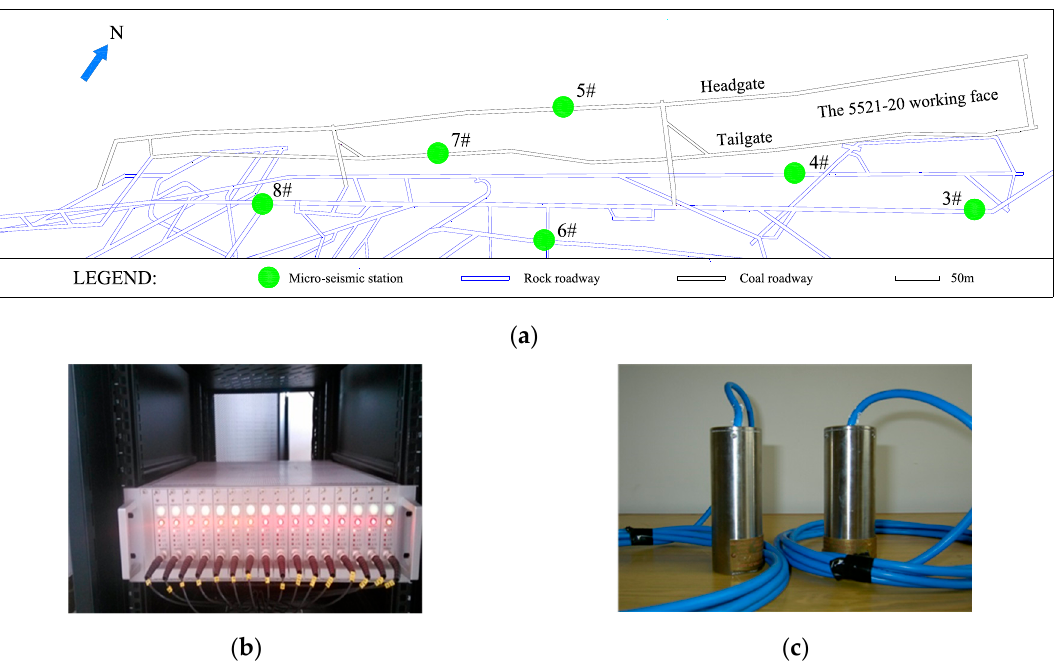
Figure 12. SOS micro ‐ seismic monitoring system: ( a ) Dispersion of micro ‐ seismic stations; ( b ) DLM ‐ SO signal acquisition station; and ( c ) Vibration sensors.